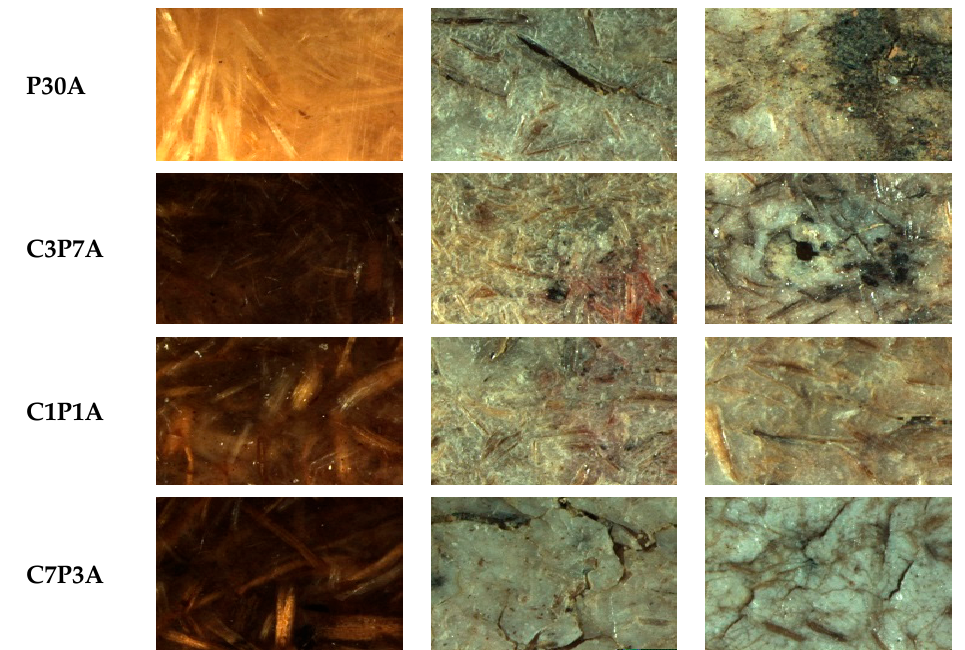
Figure 6. Image Analyser photographs of soil-degraded and unburied PLA sheets and CF/PALF/PLA